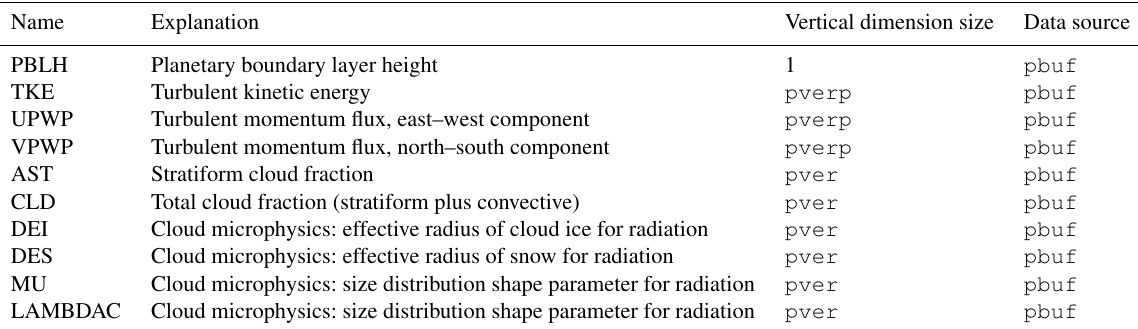
Table A2. Candidate condition metrics and QoIs that are directly copied from EAM’s “physics buffer” data structure. pver and pverp are EAM’s variable names for the number of vertical layers and layer interfaces, respectively. In the standard v1 model, pver is 72 and pverp is 73. More candidate metrics and QoIs can be added following existing examples in subroutine get_values in module conditional_diag_main